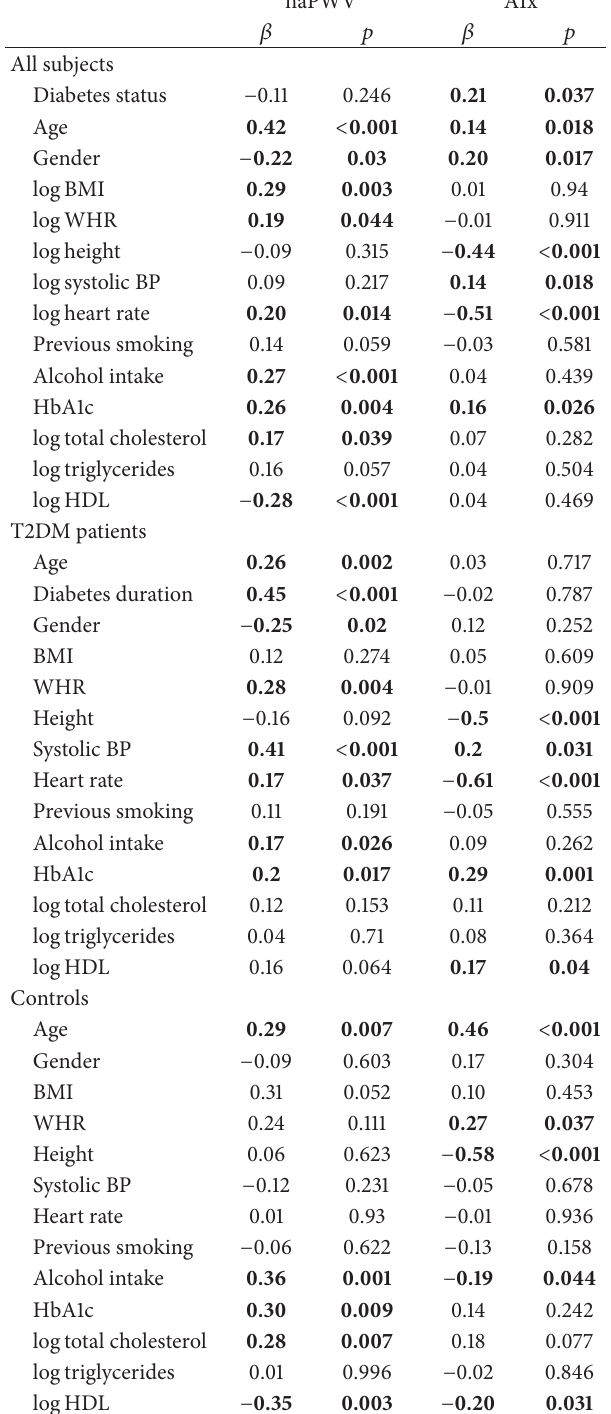
Table 3: Multiple regression analysis between patients’ characteris- tics versus haPWV and augmentation